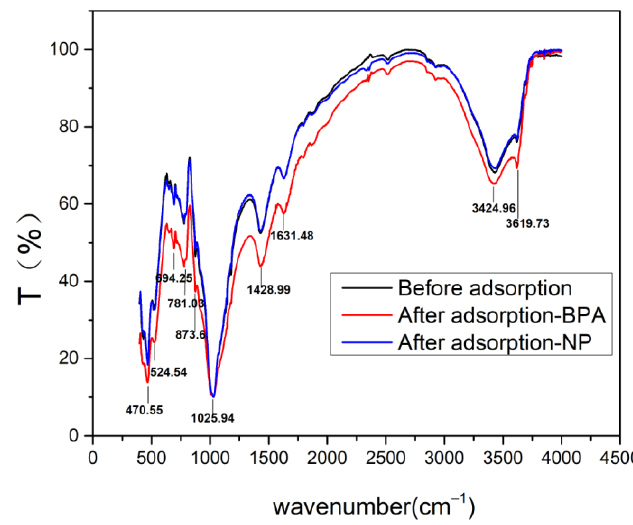
Figure 6. FTIR spectra of adsorption of NP and BPA on soil. There were no big differences of spectrums for soil and soil after NP adsorption.